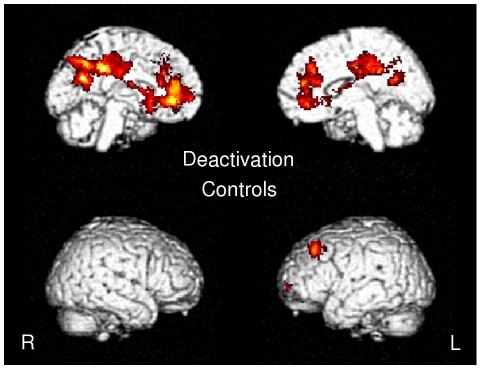
Map of deactivation in controls.